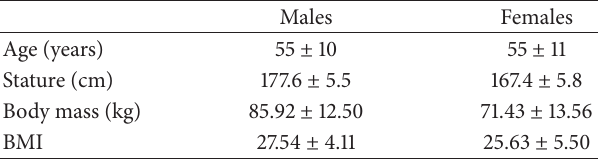
Table 1: Participant demographic characteristics (Mean ±